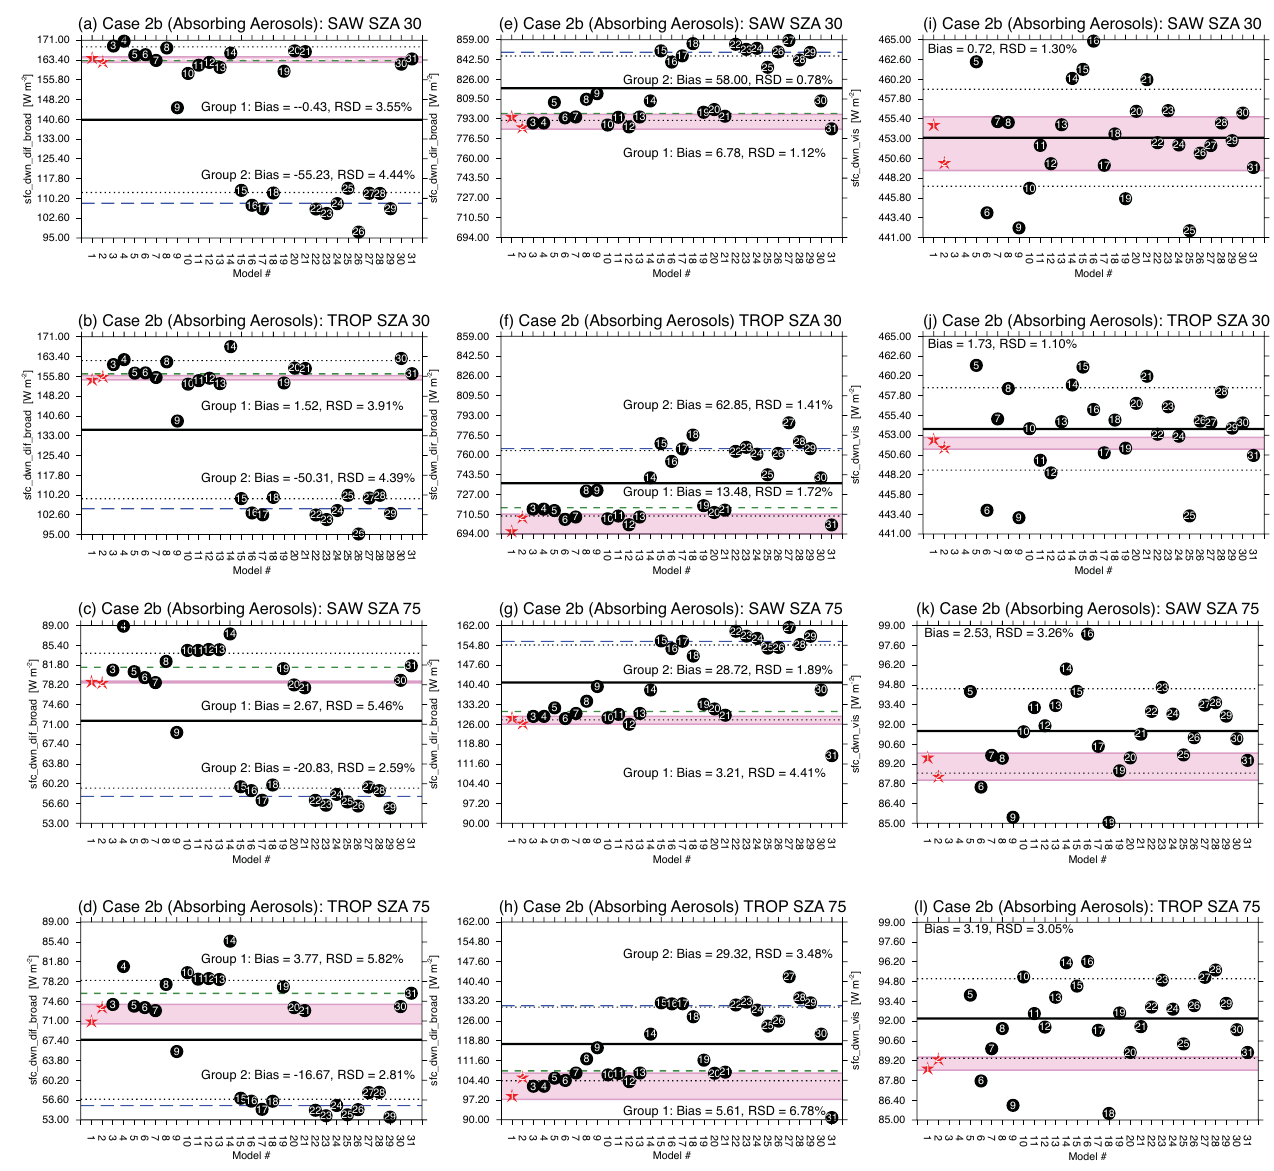
Fig. A6. The same as Fig. A5 except for Case 2b (Absorbing Aerosols). delta-four-stream approximation or a delta-two-stream (Ed- dington) approximation. It and accounts for the